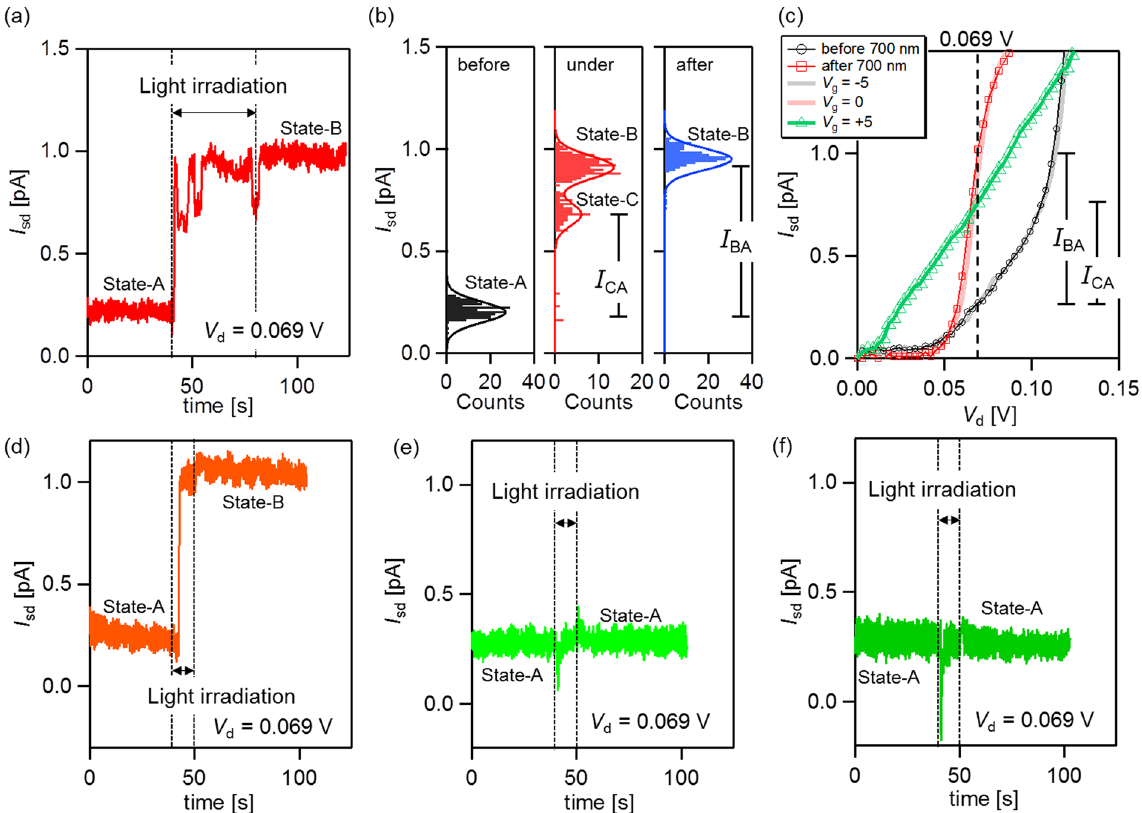
Figure 2. I sd − t characteristics before, under, and after light irradiation ( V d = 0.069 V) at ( a ) 700 nm, 280 μ W/ mm 2 ; ( d ) 600 nm, 52 μ W/mm 2 ; ( e ) 520 nm, 128 μ W/mm 2 ; and ( f ) 500 nm, 79 μ W/mm 2 . ( b ) Histograms of the current before, under, and after 700-nm light irradiation. Each fitting curve comprises Gaussian functions. ( c ) I sd − V d characteristics before and after irradiation with 700-nm light and V g = − 5, 0, 5